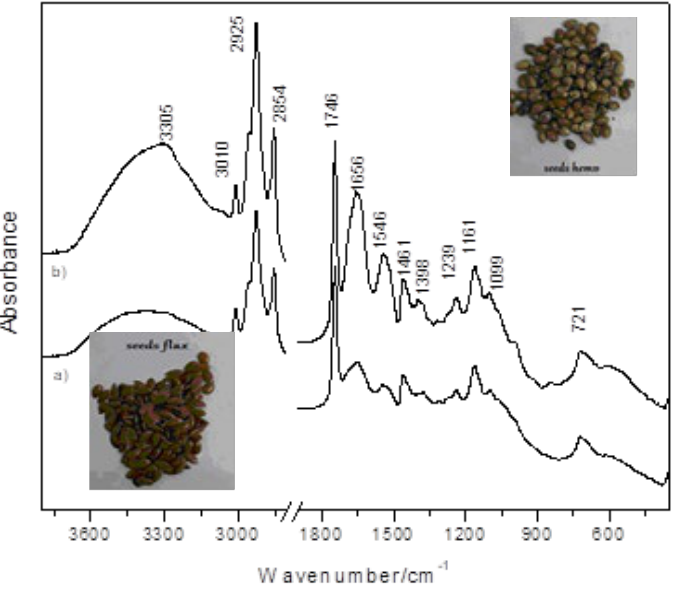
Figure 1. FT-IR spectrum of flax seeds ( a ) and hemp seeds ( b